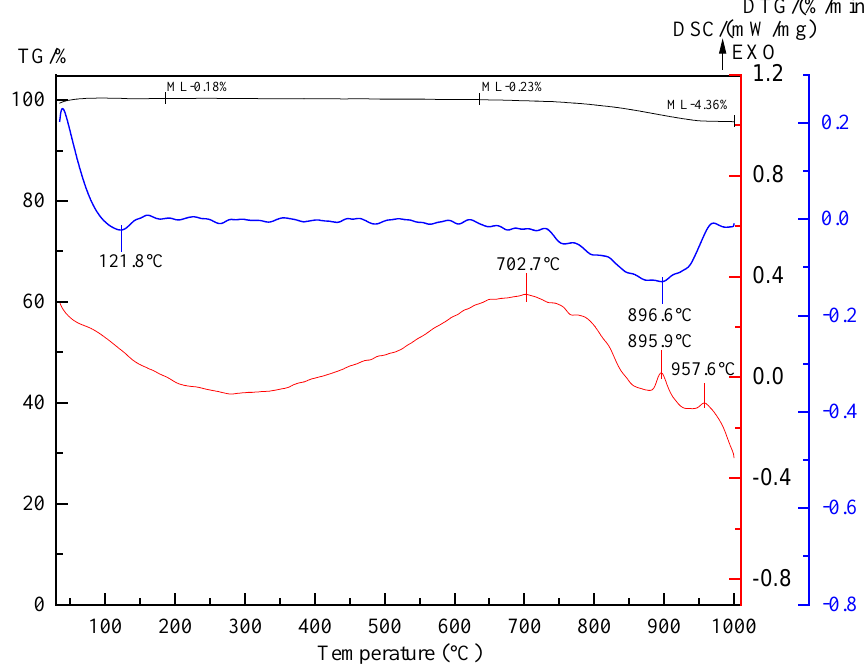
Figure 5. Thermal analysis curves of pure muscovite (99.9 wt %): mass loss (ML), exothermic (EXO).